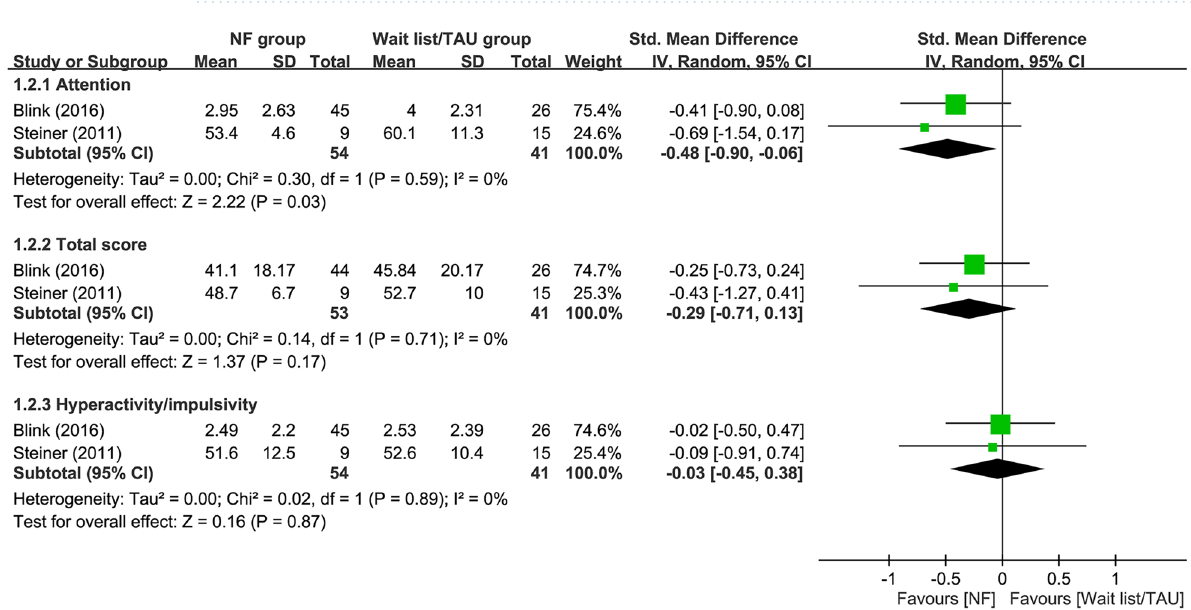
Figure 4. Forest plot for comparing symptoms of attention-deficit hyperactivity disorder between EEG-NF and comparison groups. CI, confidence interval; IV, inverse variance; Std, standardized.